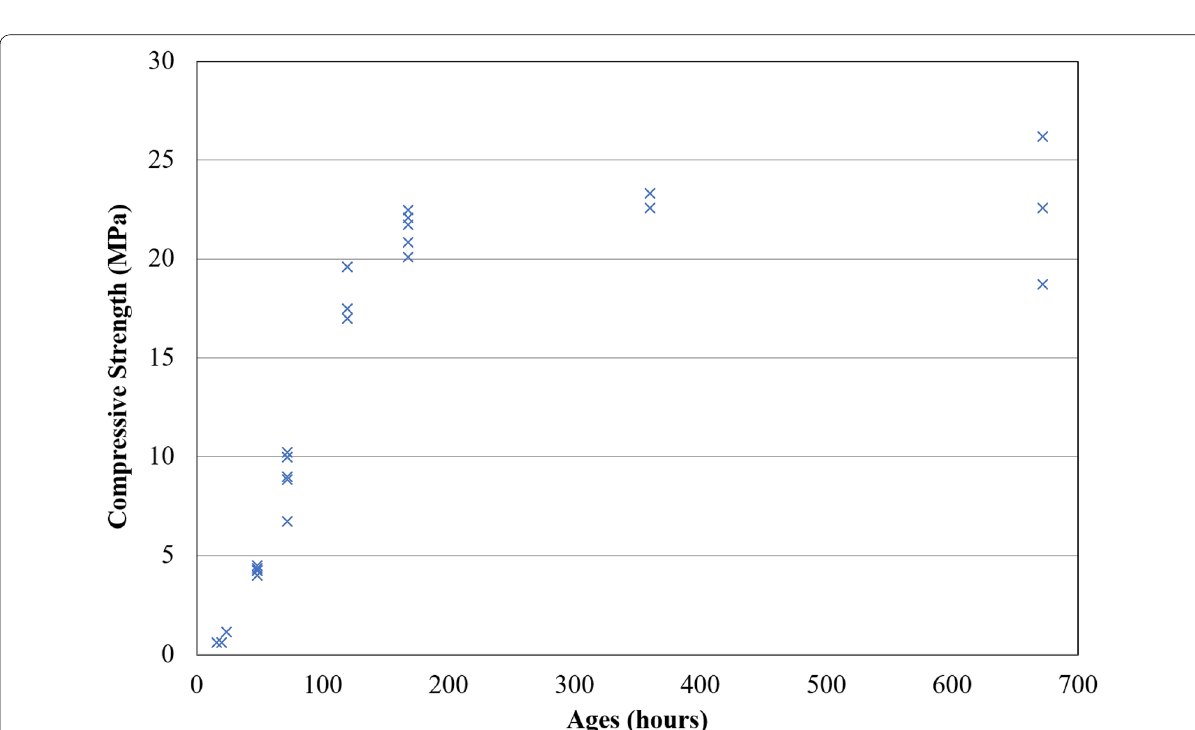
Fig. 5 Compressive strength with ages (30